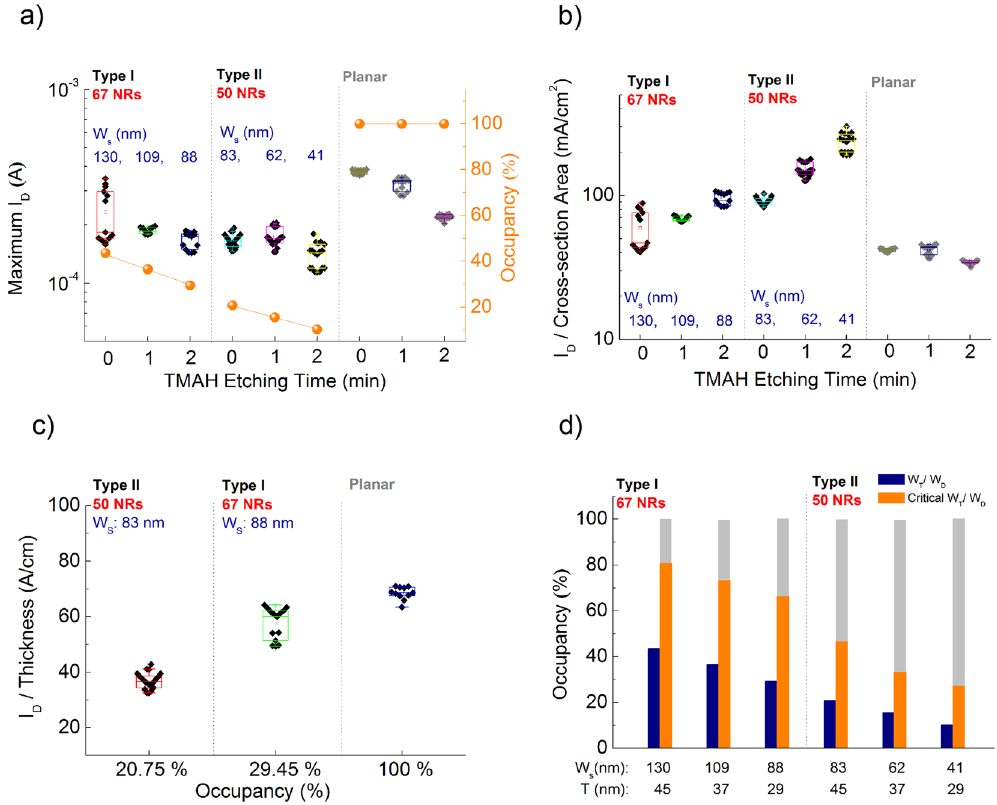
Figure 6. Maximum I D ( a ) and I D density ( b ) with respect to TMAH etching time. Maximum I D was collected at V g of 40 V and V D of 10 V from each transfer curve. Occupancy, y-axis on the right side, was calculated by W T / W D . Cross-sectional I D density was estimated by dividing maximum I D by active region ( W T × T ). ( c ) Correlation of I D to the number of NRs. I D levels from similar size NRs were normalized by each thickness for comparison. ( d ) Occupancy of NRs within the W D depending on TMAH etching (blue). Critical occupancy of NRs that is required to obtain the same I D level of as planar TFT is shown in orange. Higher occupancies, shown in gray, will give I D greater than does the planar TFT.